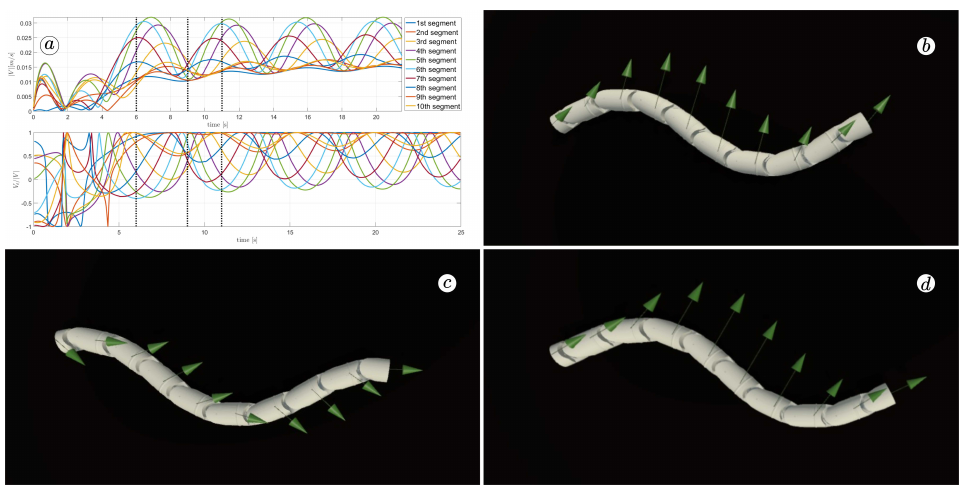
Figure 17. Absolute value and tangential component of segments velocities for c t = 0.1 and c n = 10 ( a ) and velocity vectors for t = 6 ( s ) ( b ), t = 9 ( s ) ( c ), and t = 11 ( s ) ( d ).